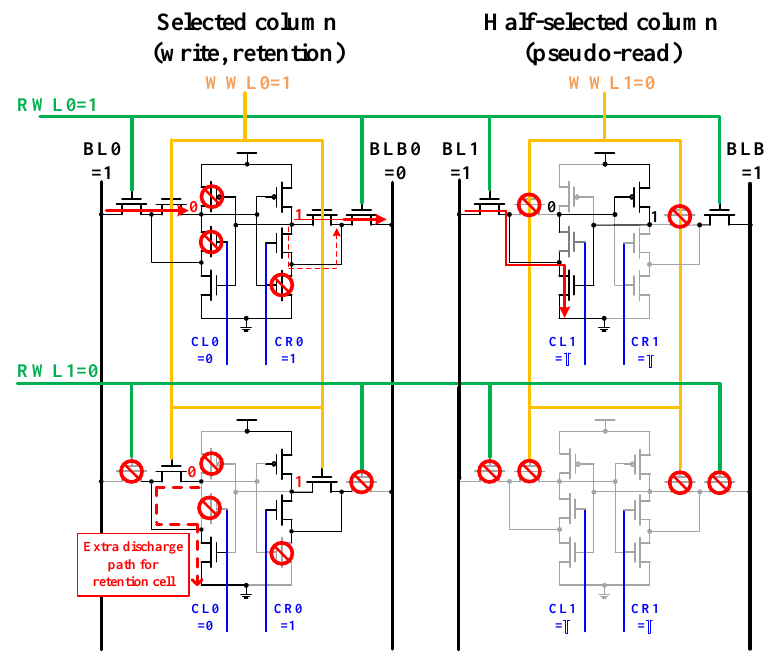
Figure 7. Write half-selected analysis of the proposed design.